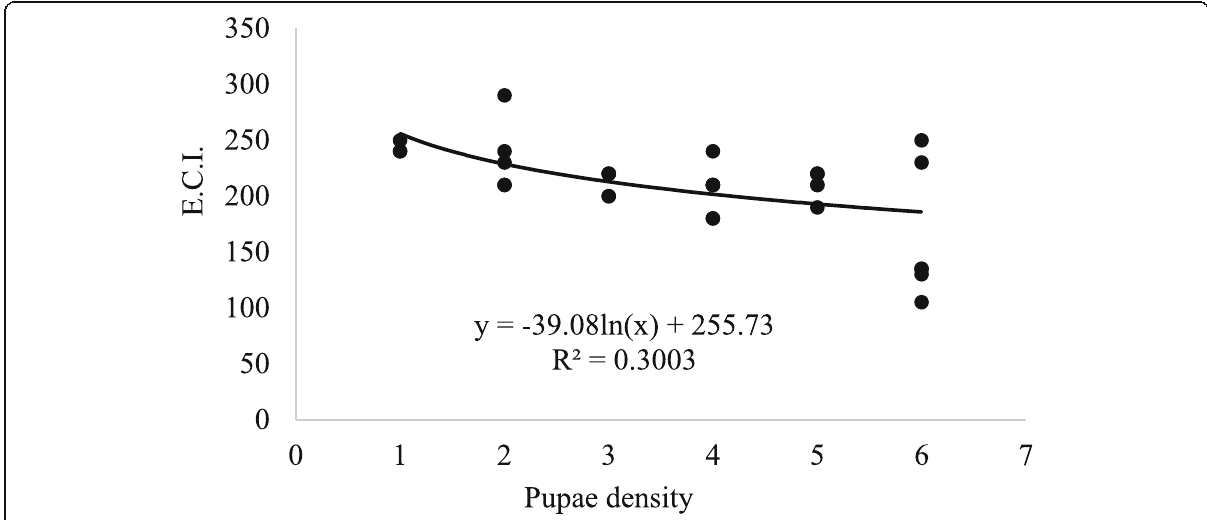
Fig. 8 Relationship between efficiency of ingested feed conversion (ECI) to egg biomass of A. biannulipes at varying densities of P. truncatus